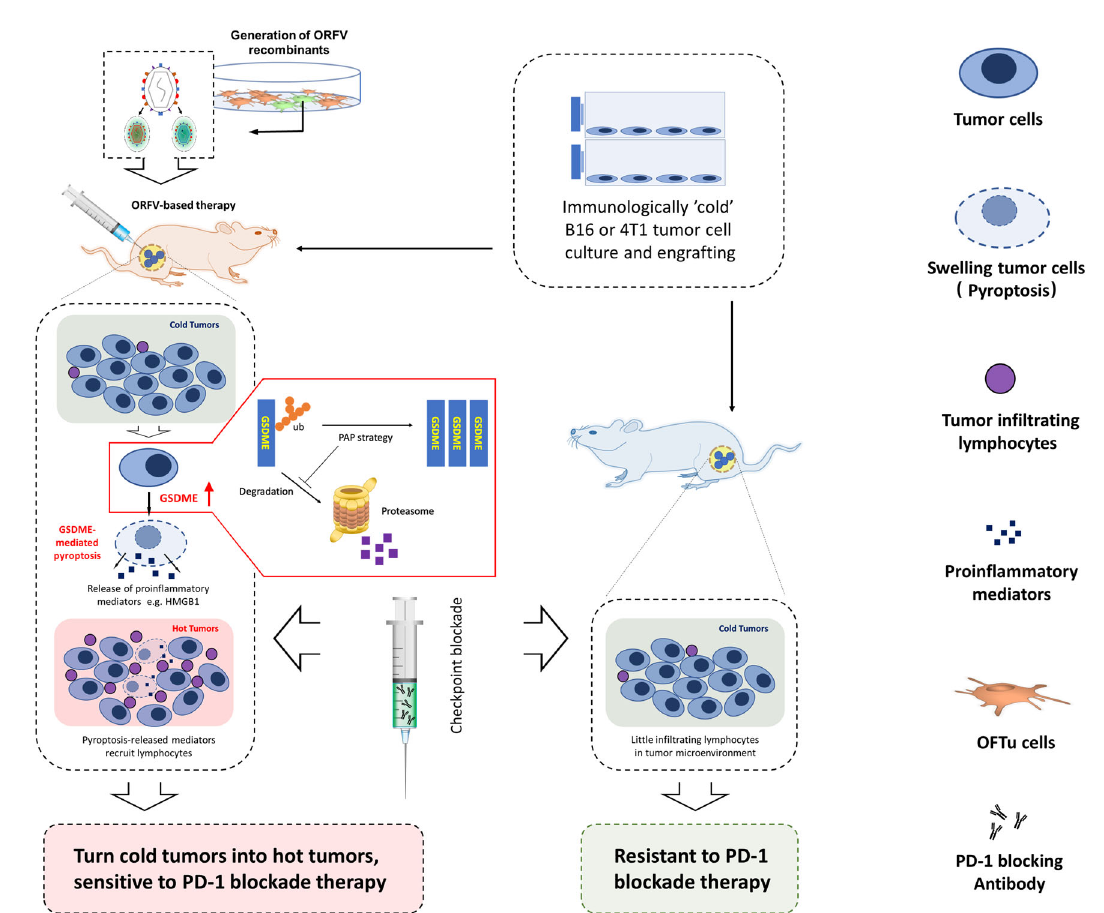
Fig. 7 | ORFV induces GSDME-mediated pyroptosis and activates antitumor immunity. We can generate different ORFV recombinants with one or two genes deletion, which are armed with the EGFP gene for imaging. WT ORFV and ORFV recombinants are able to trigger GSDME-mediated pyroptosis in tumor cell lines, in vivo tumor tissues, and ex vivo human colon cancer tissues. ORFV can pre- stabilize GSDME protein levels in GSDME-low tumor cells through decreasing ubiquitination of GSDME, which was followed by GSDME cleavage and